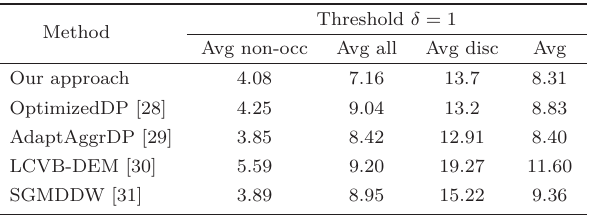
Fig. 2 Effect of window size variation for SGFD and other cost functions. Table 1 Comparison of methods on MV2 using δ = 1 Table 2 Comparison of methods on MV2 using δ =